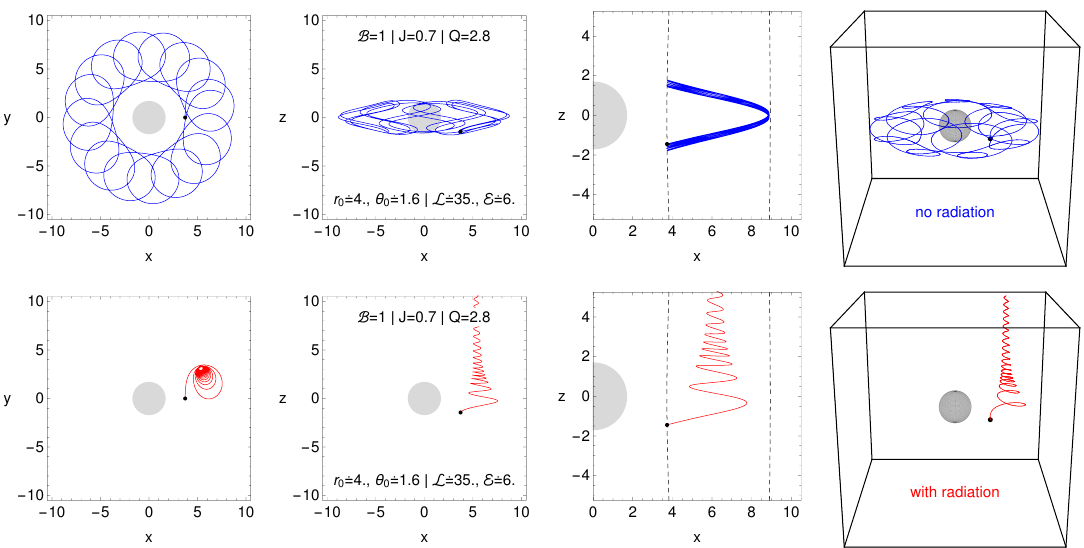
Figure 20. Representative comparison of trajectories of non-radiating (first line) and radiating (second line) charged particles around rotating Kerr black hole in a magnetic field. Initial conditions in both cases are chosen to be same and shown in the second row plots. The starting point is indicated by black dot. A radiating charged particle will radiate away its dynamical energy related to the Larmor precession and escape to infinity along magnetic field line aligned with the z